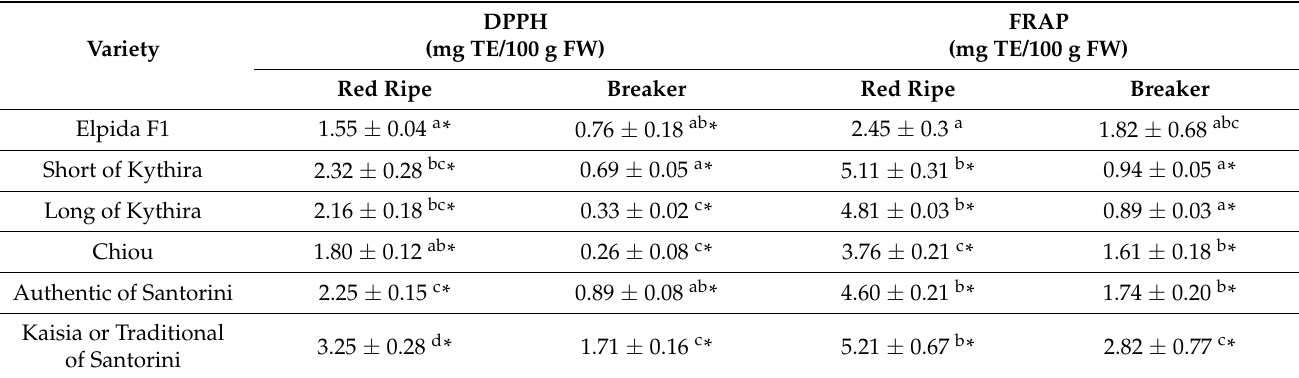
Table 5. Lipophilic antioxidant activity (LAA) of tomatoes at red ripe and breaker ripening